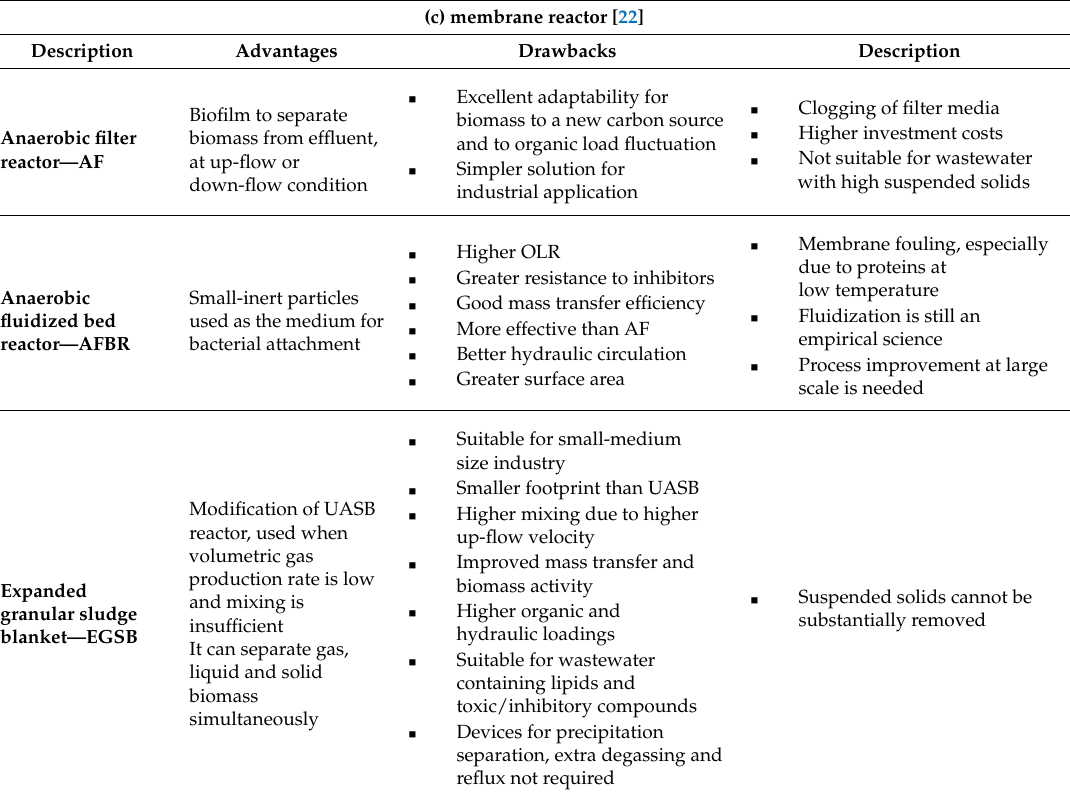
Table 2. Cont. (c) membrane reactor